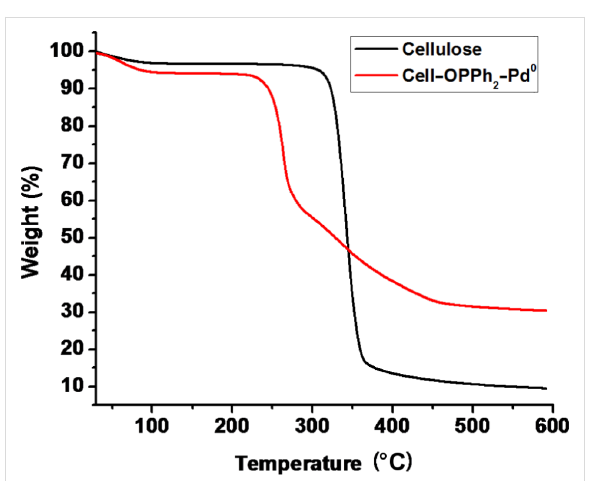
Figure 2: TG curve of the cellulose and Cell–OPPh 2 –Pd 0 under nitrogen